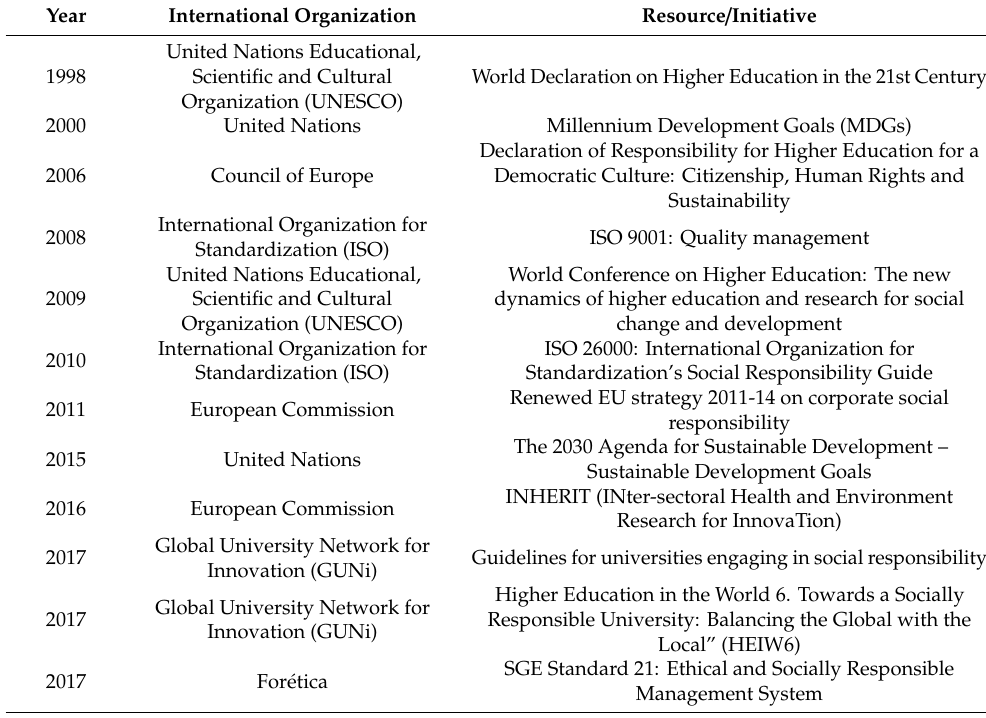
Table 2. University Social Responsibility: definitions, policies, projects, regulations, normative and